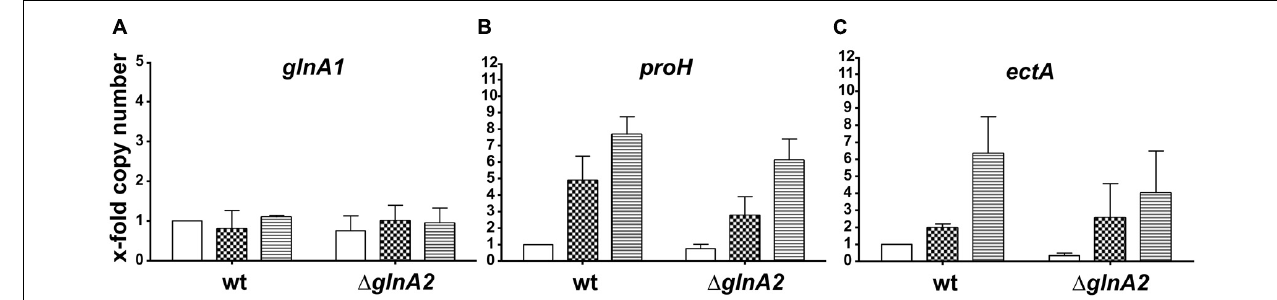
FIGURE 5 | Cellular transcript levels of glnA1 (A) , proH (B), and ectA (C) in Halobacillus halophilus wild type and (cid:2) glnA2 mutant. Cellular transcript levels were detected in cells grown in G10 medium containing 1.0 (no fill), 2.0 (squares), or 3.0 (horizontal lines) M NaCl and harvested in the